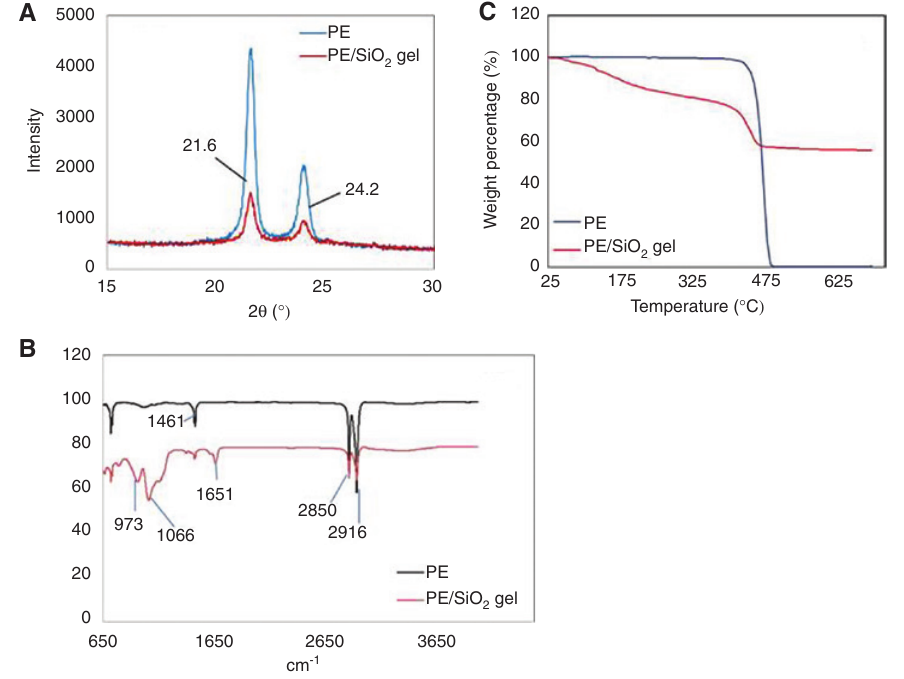
gel composites from (A) XRD, (B) FTIR, and (C) 2